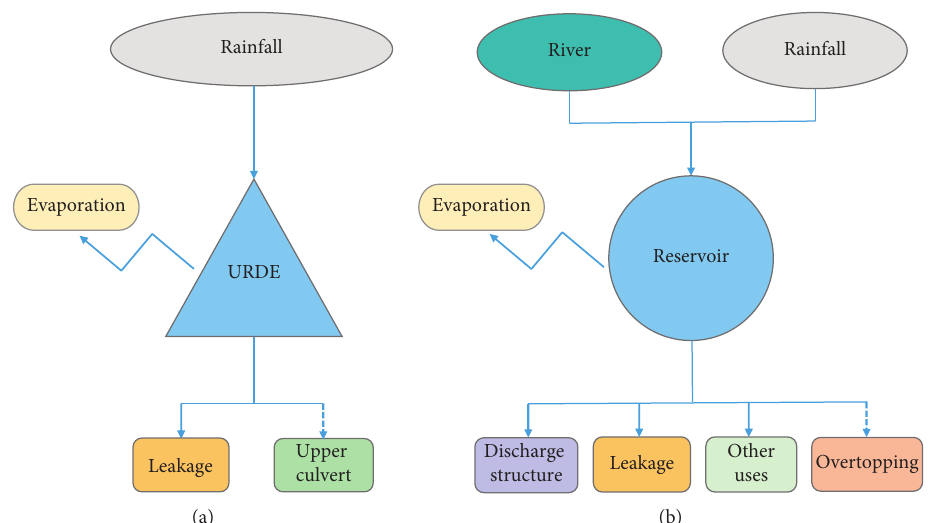
Figure 13: (a) Water replenishment and loss in the upstream reservoir of dam embankment (URDE); (b) water replenishment and loss in common